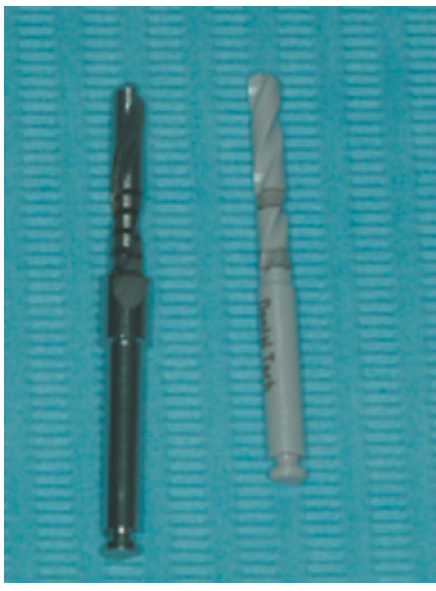
Figure 1. Macroscopic aspect of the steel drill (left) and zirconia drill (right) used in the present study.